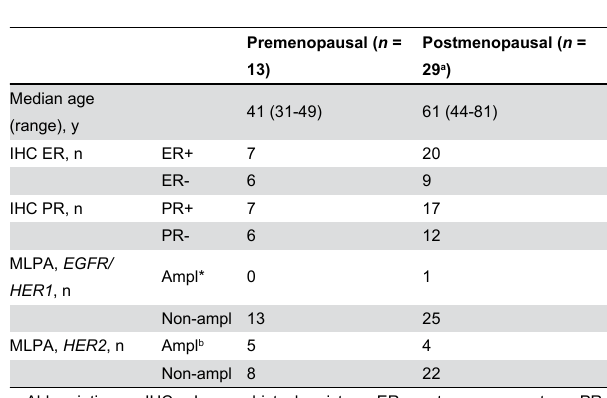
Table 1. Primer sequences and UPL probes used for real- time PCR.